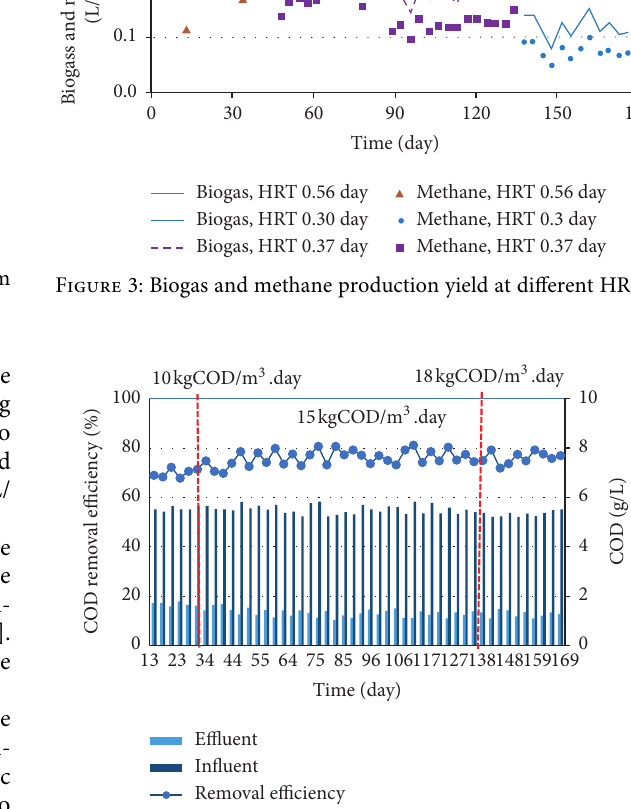
Figure 4: COD removal efficiency at different